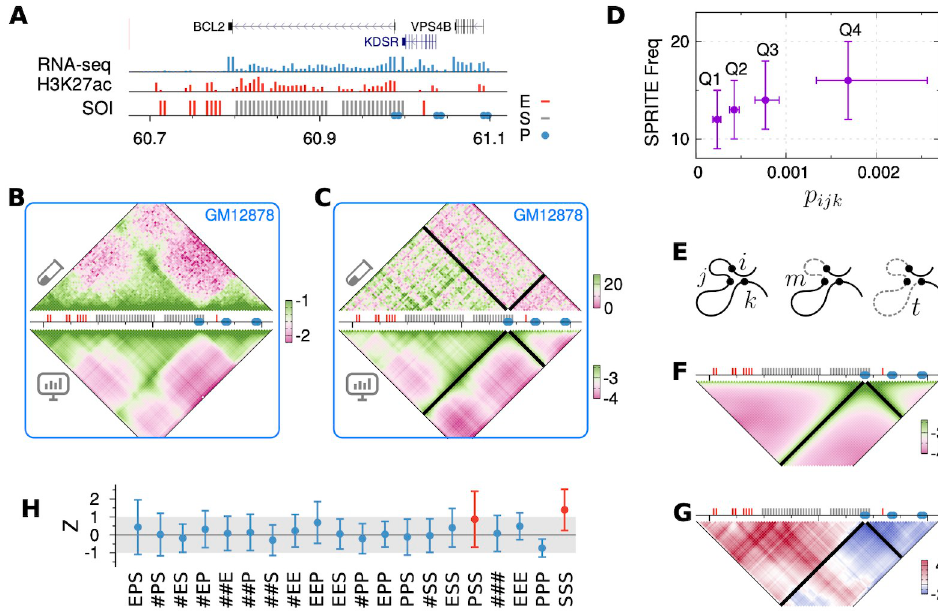
Fig 5. Comparing triplet contact predictions with SPRITE. (A) Genes, RNA-seq and H3K27ac ChIP-seq signals [60, 67] in a 0.45 Mb region on human chr18 with the positions of three types of SOIs (Enhancers, Promoters and Super- enhancers). (B) log 10 ( p ij ) from Hi-C compared with that from HLM at 5-kb resolution. (C) The triplet contact frequency from SPRITE is compared with log 10 ( p frequency of triplets which are divided into four quantiles based on ascending order of p ijk . (E) For three sites, i < j < k , along a polymer chain, the minor and major sections denoted by m and t , respectively, are depicted with dashed lines. (F) The expected three-body contact probability � p mean specificity Z-score of triplet contacts with respect to all possible combinations of annotations (E: Enhancers, P: Promoters, S: Super-enhancers, #: sites without any annotation). The error bars are the standard deviations.